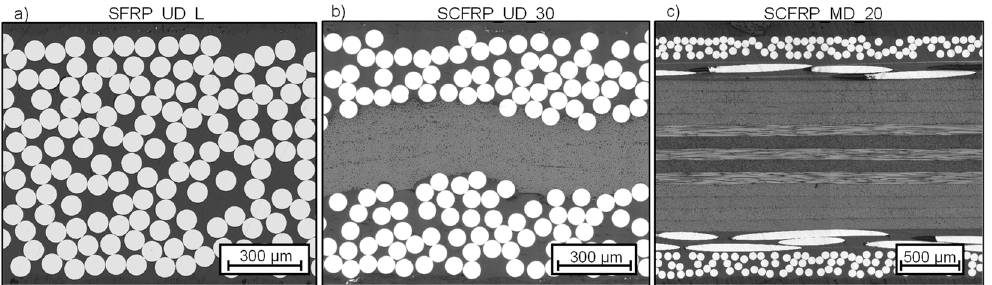
Figure 3. Micrographs of the SFRP_UD_L laminate in ( a ), the SCFRP_UD_30 laminate in ( b ), and the SCFRP_MD_20 laminate in ( c ).